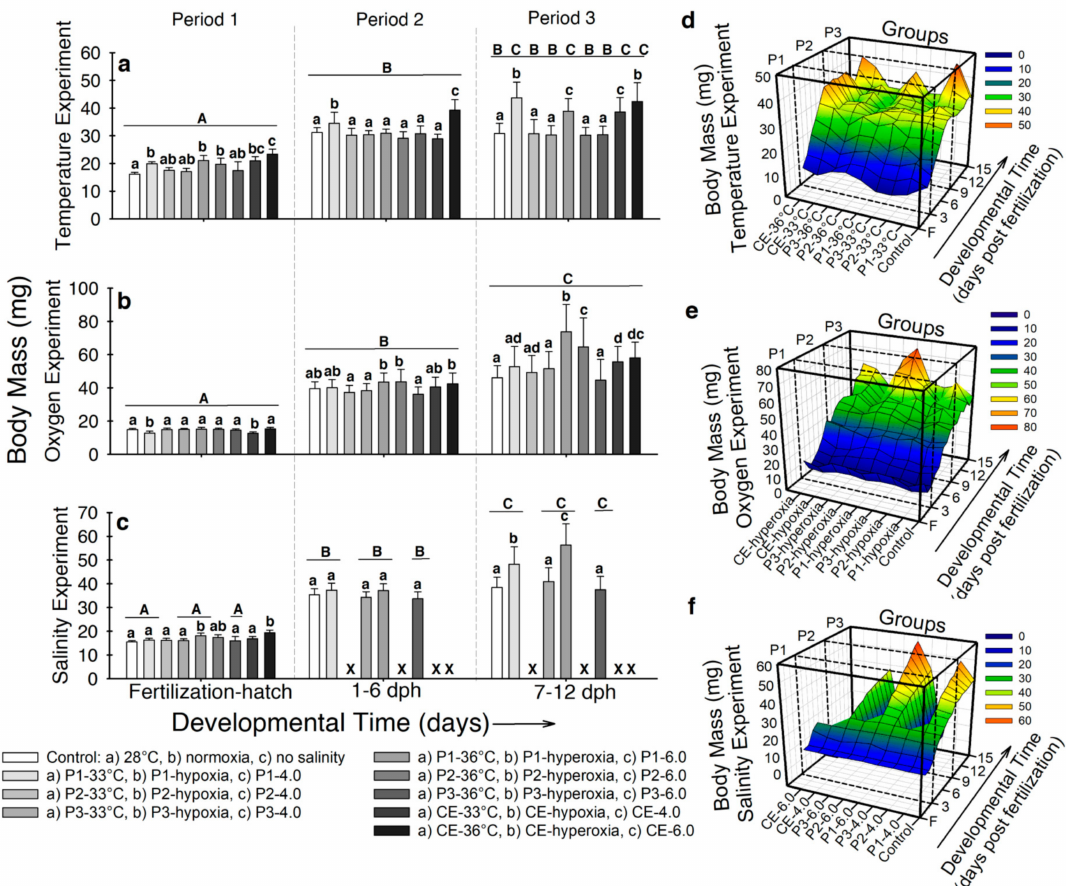
Figure 2. Body mass (BM) of Atractosteus tropicus at the end of each developmental period for ( a ) temperature, ( b ) air saturation, and ( c ) salinity experiments. Means ± SEM are presented. Lowercase letters represent differences between experimental groups from each developmental period ( p < 0.001). Capital letters indicate differences within developmental time for each experimental group ( p < 0.001). Panels ( d – f ) show the relation between development, treatments, and effect on the body mass of the fish in the whole experiments for temperature, air saturation, and salinity, respectively. Control conditions: 28 ◦ C, 0.0 ppt of salinity, normoxia (95% air saturation); treatments 1: 33 ◦ C, hypoxia (~30% air saturation), or 4.0 ppt of salinity respectively to each experiment; treatments 2 (independently for each experiment): 36 ◦ C, hyperoxia (117% air saturation), or 6.0 ppt of salinity respectively to each experiment. Black crosses (X) in the salinity experiment represent groups where all fish died. n = 20 for each